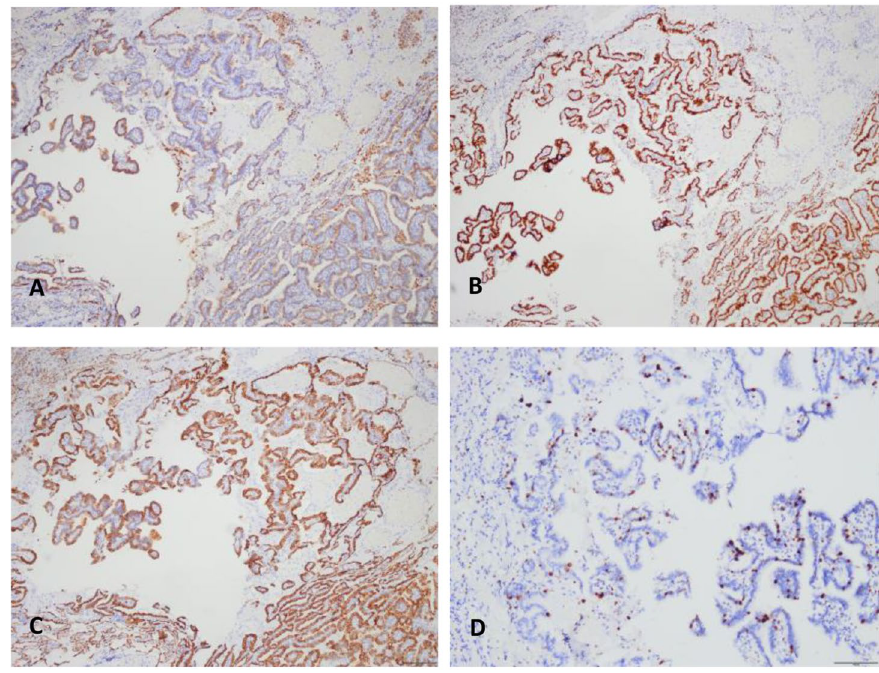
Fig. 4 Immunohistochemical staining of the tumor. A, B, C, The tumor cells were diffusely positive for NapsinA, TTF-1, and CK7 (40×). D, Ki-67 proliferative index was about 6%, and even close to 20% in hot spots